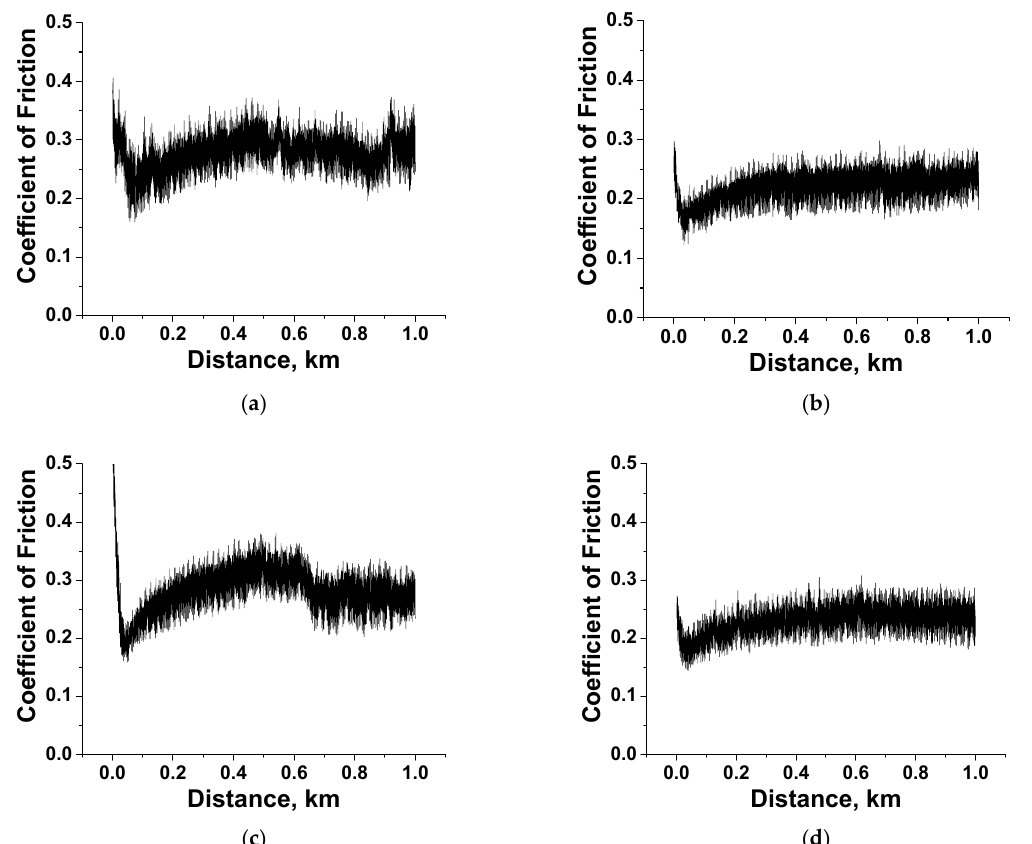
Figure 8. The time dependence in the CoF values for the PI/10CCF/1CNT ( a ), PI/10CCF/1HNT ( b ), PEI/10CCF/1CNT ( c ) and PEI/10CCF/1HNT ( d ) nanocomposites. Linear tribological contact. P = 60 N, V = 0.3 m/s.